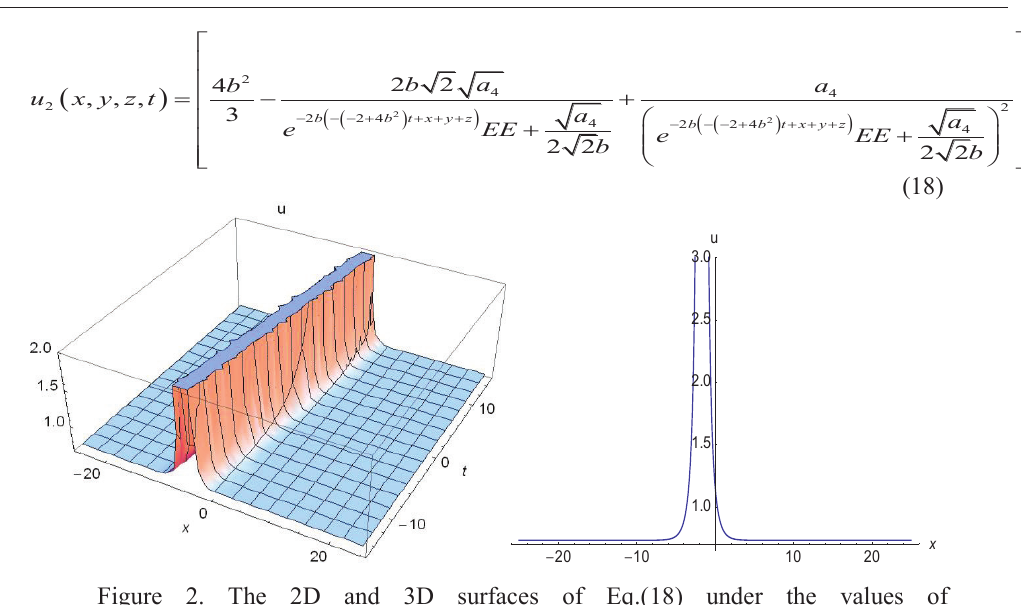
Figure 1. The 2D and 3D surfaces of Eq.(16) under the values of